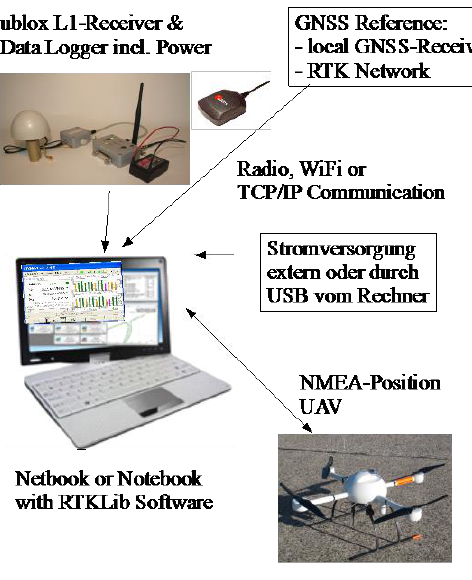
Figure 1, Overall Low-cost RTK GNSS System